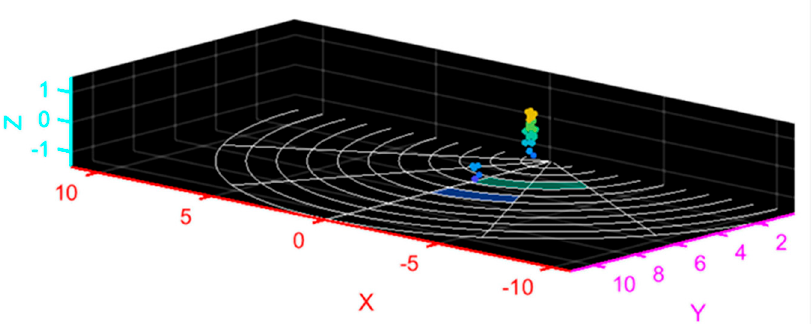
Figure 3. Point cloud collection.